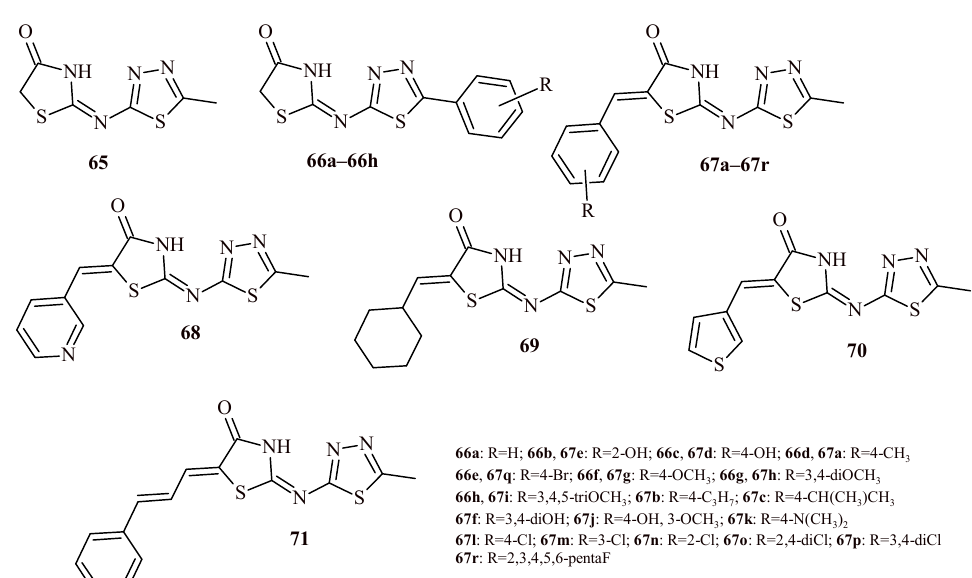
Figure 28. The structures of thiazolidin-4-one-1,3,4-thiadiazole hybrids with dual COX-2 and 15-LOX anti-inflammatory activity.